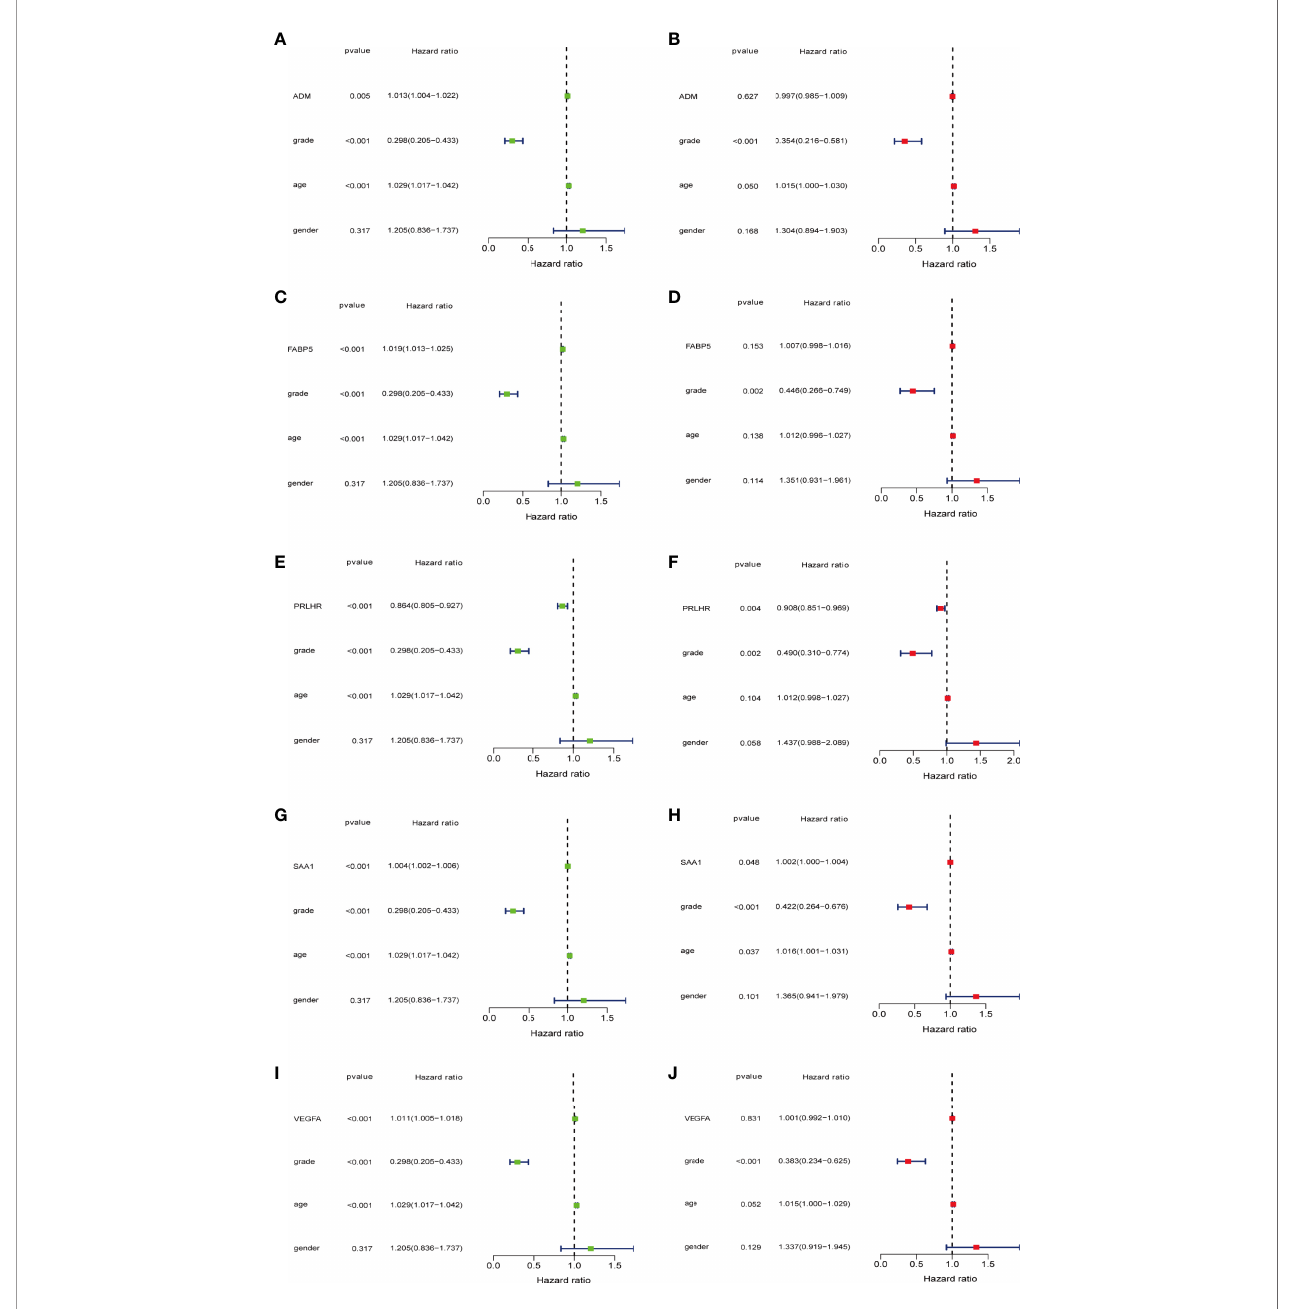
FIGURE 6 | 5-DEmRNAs are analyzed separately with age, gender, and tumor grade for independent prognostic analysis. (A, C, E, G, I) Single factor Cox regression analysis. (B, D, F, H, J) Multivariate Cox regression analysis. PRLHR can be used as an independent prognostic factor for patients with